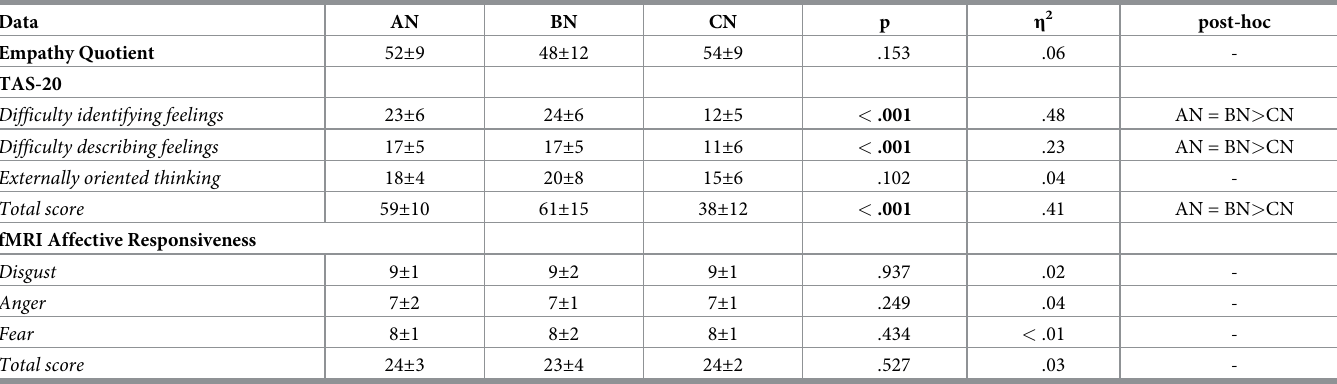
Table 3. Self-reported empathy, alexithymia, and behavioral performance during affective response task for the three